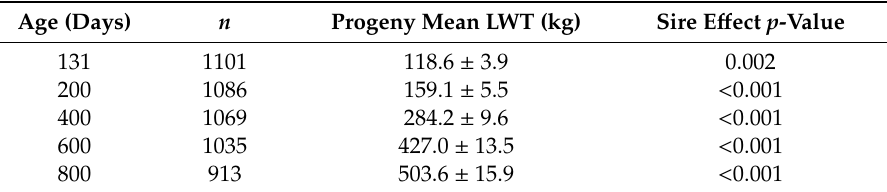
the sire had no e ff ect on live weight at any age from 131 to 800 days ( p > 0.05). Cattle grew at an overall rate of 0.58 kg / day, with a mean of 0.59 kg / day from 131 to 200 days, 0.63 kg / day from 200 to 400 days, 0.71 kg / day from 400 to 600 days and 0.38 kg / day from 600 to 800 days. Di ff erences in live weight between the lightest and heaviest sires was 19 kg at 131 days (range 110.6–129.7 kg, inter-quartile Table 2. Number of progeny, mean (±SD) of the least-squares means of the progeny groups for live weight (LWT, in kilograms) and p -value for the effect of sire on live weight at 131, 200, 400, 600 and 800 days of age, for 73 sires.